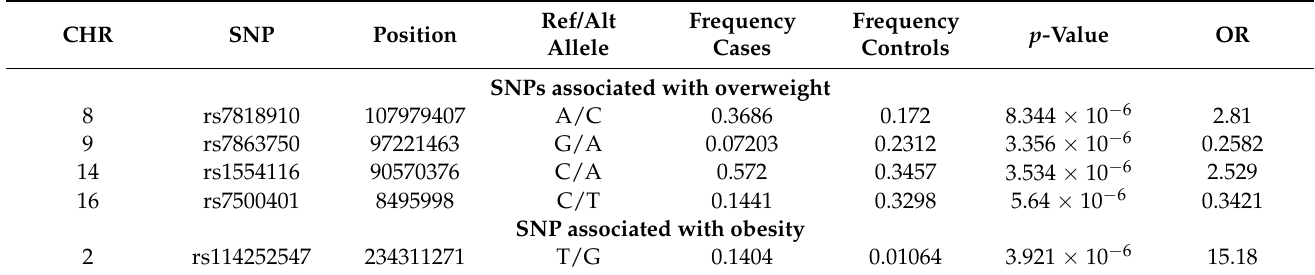
Table 2. Summary of the association results for overweight and obesity, significant SNPs, and their genomic position; Chr, chromosome; Ref/Alt, reference/altered; OR, odds ratio.